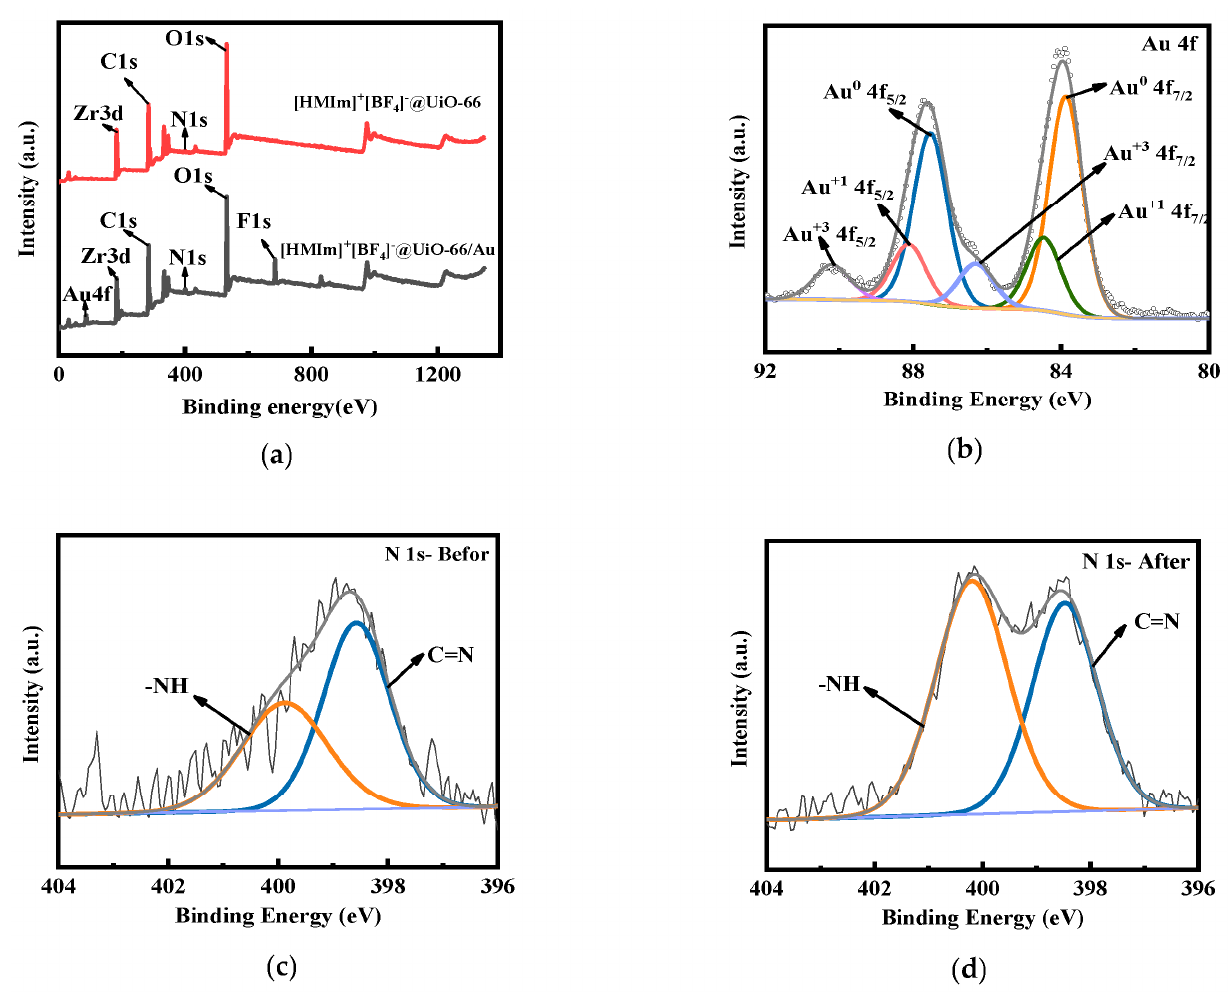
Figure 6. XPS spectra: ( a ) full spectra of [HMIm] + [BF 4 ] − @UiO − 66 and [HMIm] + [BF 4 ] − @UiO − 66/Au; ( b ) Au 4f spectra of [HMIm] + [BF 4 ] − @UiO − 66/Au; ( c , d ) N1s spectra of [HMIm] + [BF 4 ] − @UiO − 66 and [HMIm] + [BF 4 ] − @UiO − 66/Au.